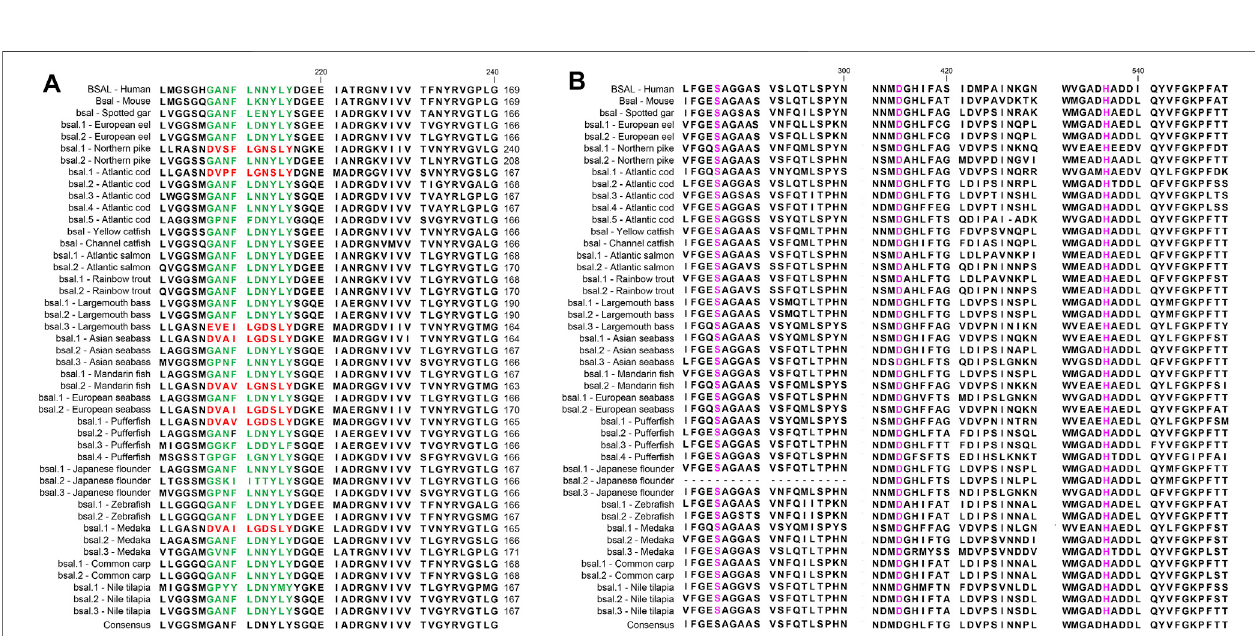
Frontiers in Genetics |